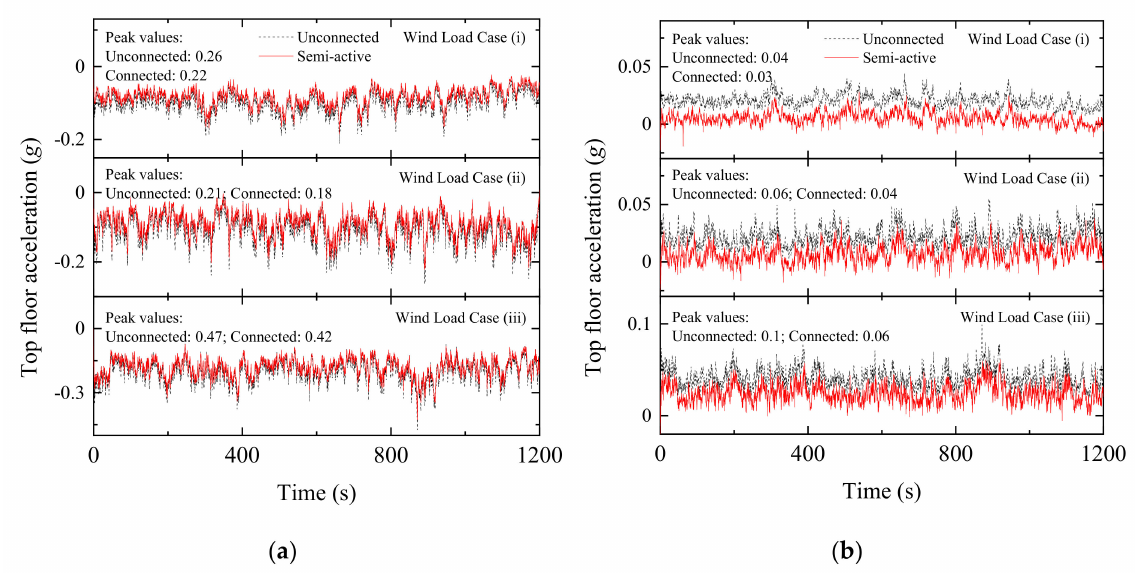
Figure 21. Time history of top floor acceleration under wind excitation in: ( a ) a building on the upwind side and ( b ) a building on the downwind side when stiff adjacent buildings are connected using semi-active MR dampers following damper Configuration